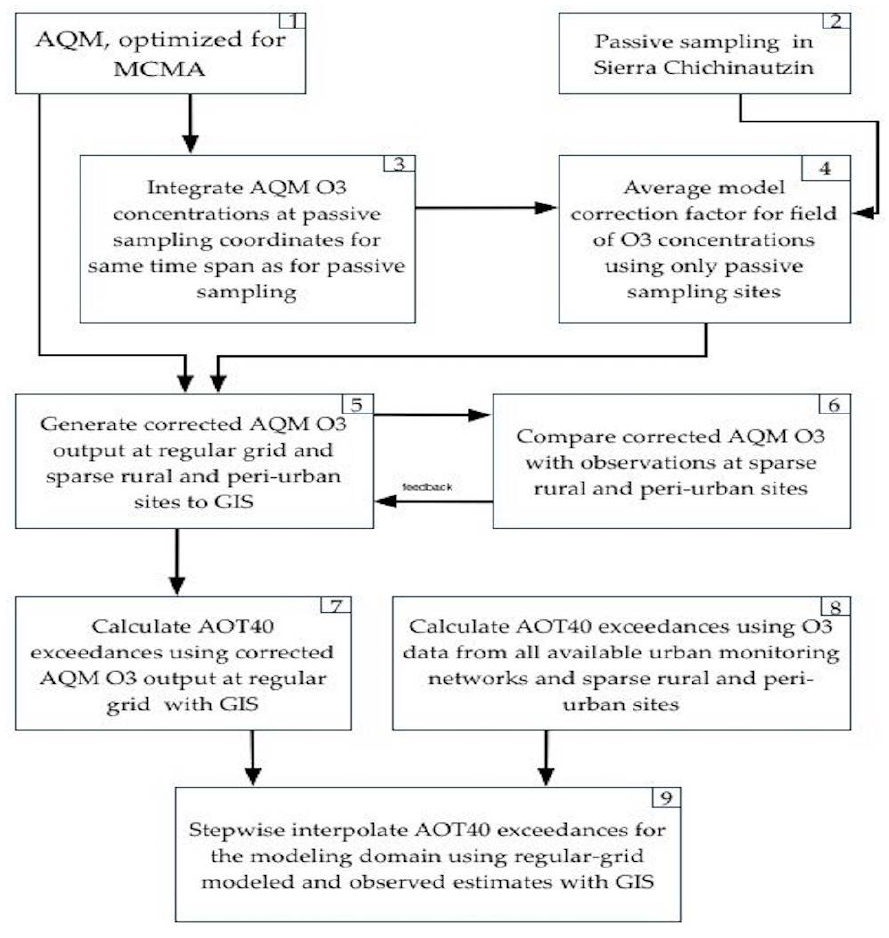
Figure 2. Conceptual model of the process used to obtain the AOT40 exceedance maps.